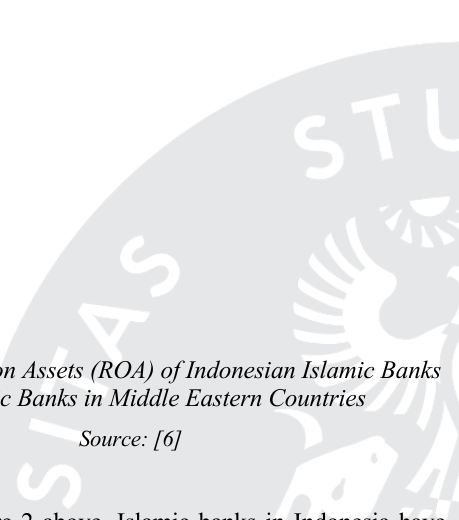
Figure 2. Return on Assets (ROA) of Indonesian Islamic Banks and Islamic Banks in Middle Eastern Countries Source: